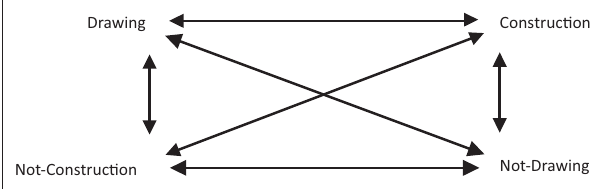
FIGURE 5: Greimassian semiotic square derived from the drawing-construction opposition.